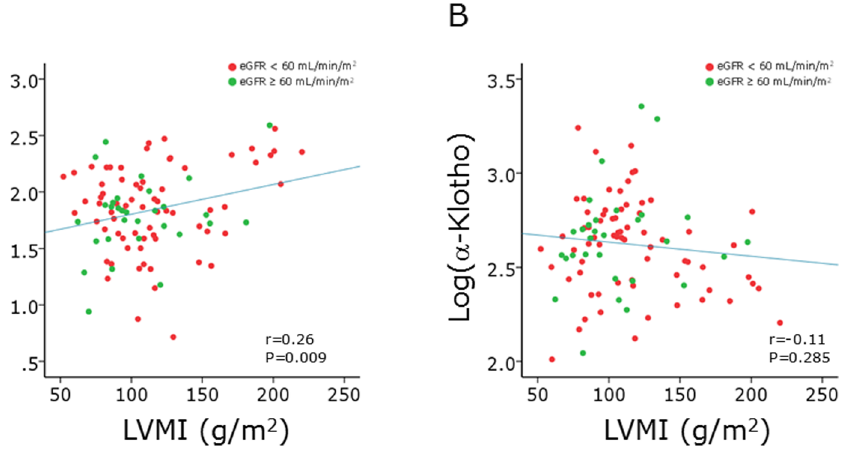
Figure 2. Correlation between FGF23, a -Klotho and left ventricular mass index (LVMI). A. Correlation between log(FGF23) and LVMI. B. Correlation between log( a -Klotho) and LVMI. Pearson’s correlation analysis was performed. Green and red closed circles indicate patients with eGFR of $ 60 mL/min/1.73 m 2 and those with eGFR of , 60 mL/min/1.73 m 2 , respectively.